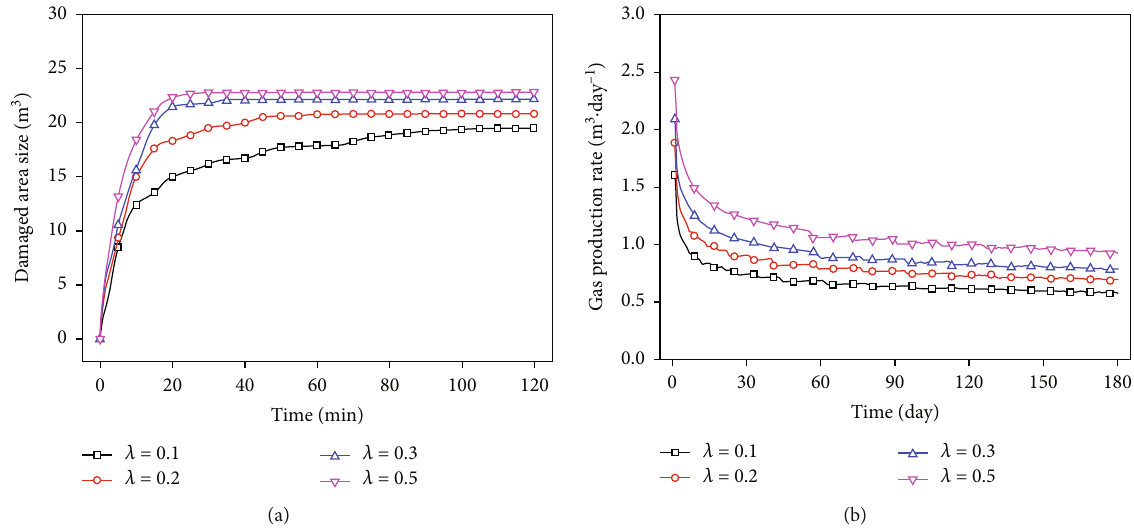
Figure 10: Damaged area size and gas production rate under di ff erent anisotropy coe ffi cients. (a) Damaged area size; (b) Gas production rate.